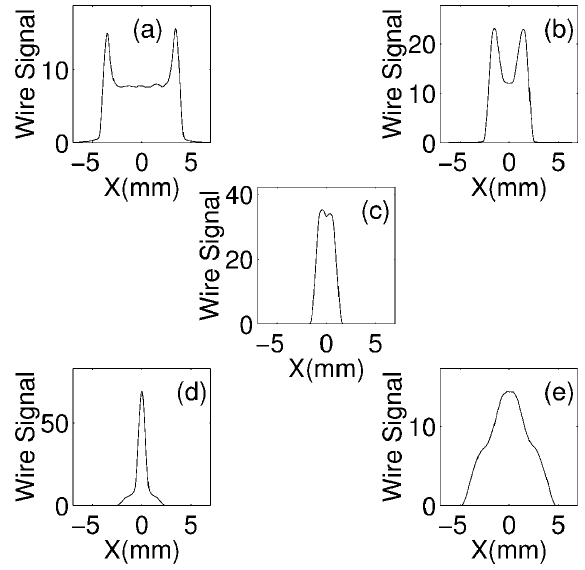
FIG. 9. Simulation of sampling wire distributions using the elliptical image algorithm to compute the